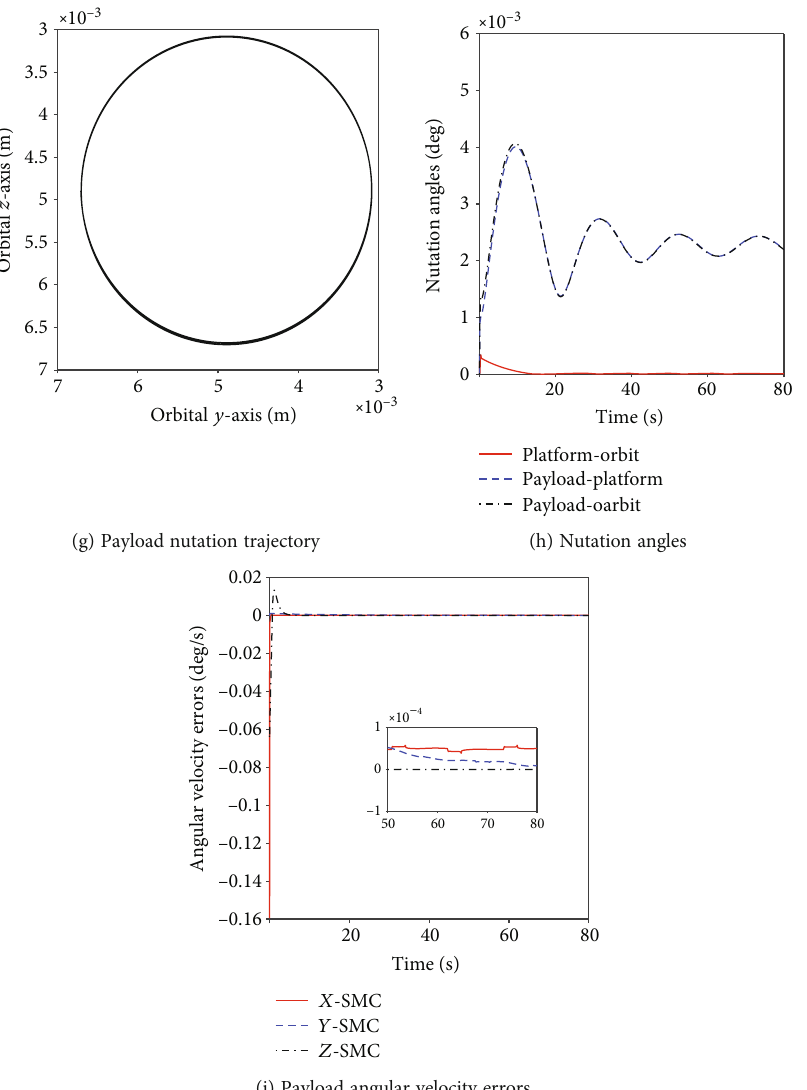
Figure 9: RPS system attitude results under the proposed